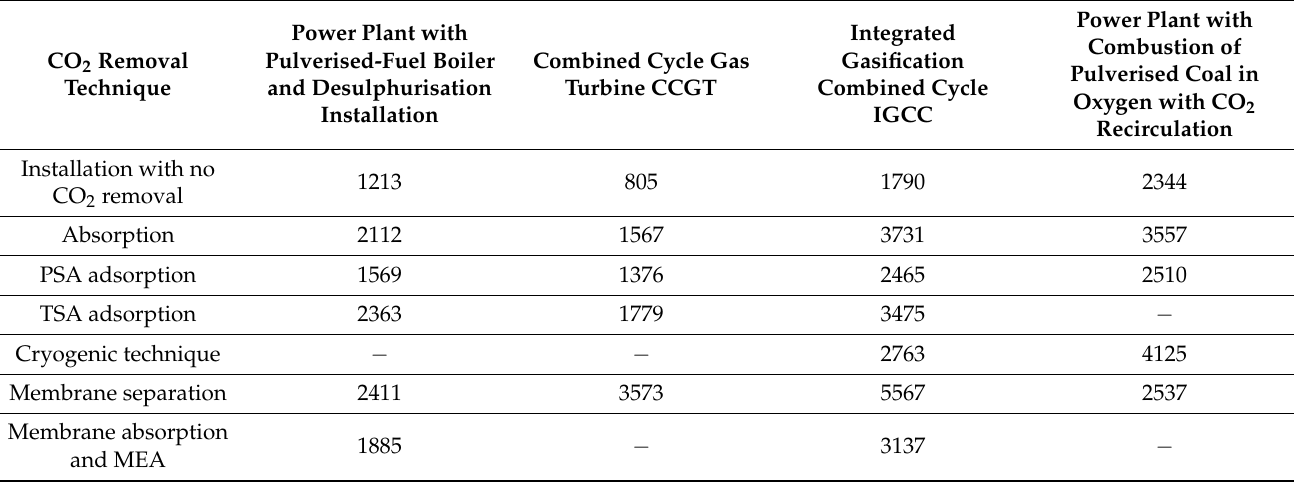
Table 1. Investment costs of selected technologies with different carbon dioxide removal techniques in EUR/kW. Source